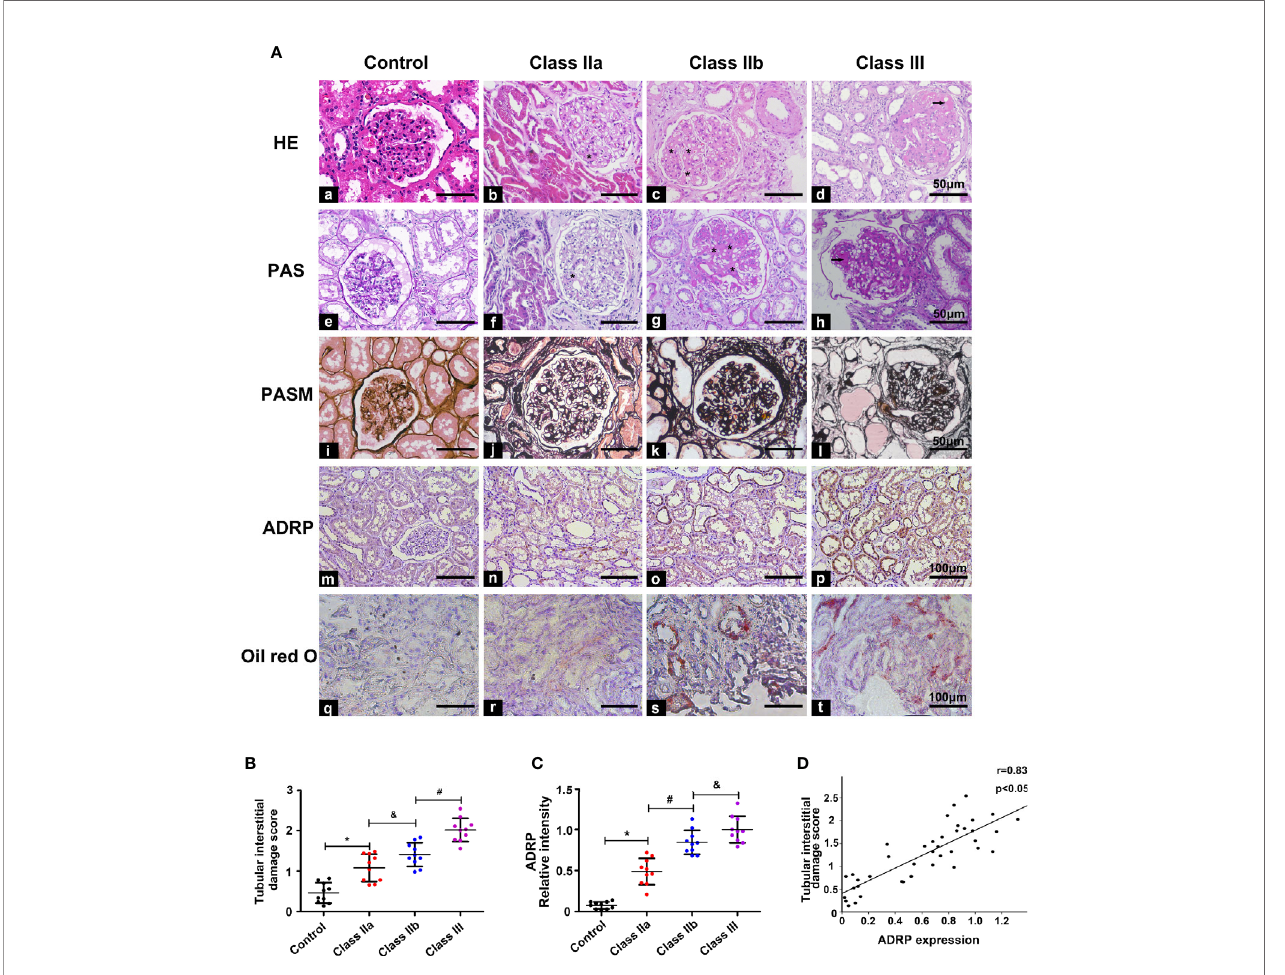
FIGURE 2 | Pathological changes and the correlation between tubulointerstitial damage and lipid deposition. One-way ANOVA was used to compare the differences among the groups, and the correlation of the two numerical variables was tested by Pearson ’ s analysis. (A) HE, PAS, Masson, IHC, and oil red O staining were used to detect pathological changes and ADRP expression in the kidney of the different groups. (B) The tubular interstitial damage score was used to assess the degree of tubular injury. (C) Scatter diagram representing the levels of ADRP. (D) Correlation analysis between the expression of ADRP and the tubular interstitial damage score. The asterisk (*) represents the notable mesangial expansion, and the arrows represent typical Kimmelstiel-Wilson lesions. Experiments were performed at least three times for each donor, with a minimum of fi ve random fi elds taken per condition. Values are the mean±SD. *p < 0.05 compared with the control group; # p < 0.05 compared with the class IIa group; & p < 0.05 compared with the class IIb